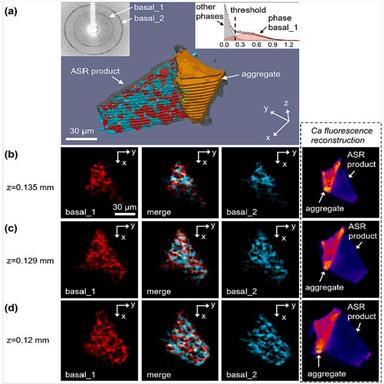
Reconstructed spatial distribution of phases (in dry condition) that produce basal peaks 10.9 Å (basal_1, red) and 7.43 Å (basal_2, cyan). (a) Volume rendering of the ASR product (red and cyan) inside the whole scanned volume (reconstructed using Ca contrast). (b–d) Compare the distribution of the phases basal_1 and basal_2 in three selected slices. A grey colour in the merged image indicates the co-existence of both phases. The corresponding slices reconstructed with Cu-Kα fluorescence signal are also disp